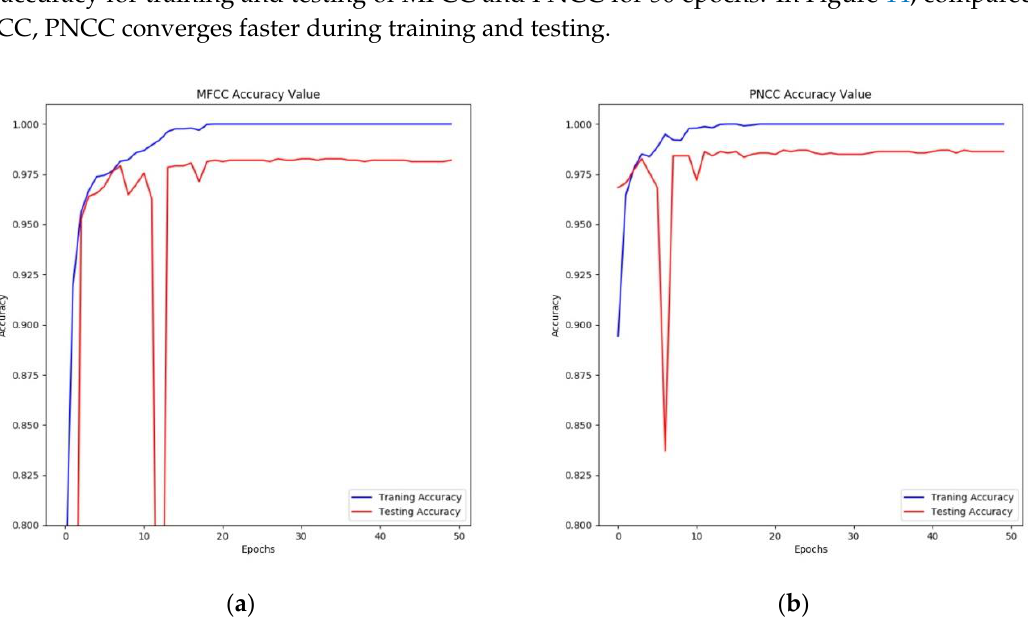
Figure 14. Accuracy depending on learning epochs: ( a ) MFCC accuracy; ( b ) PNCC accuracy.